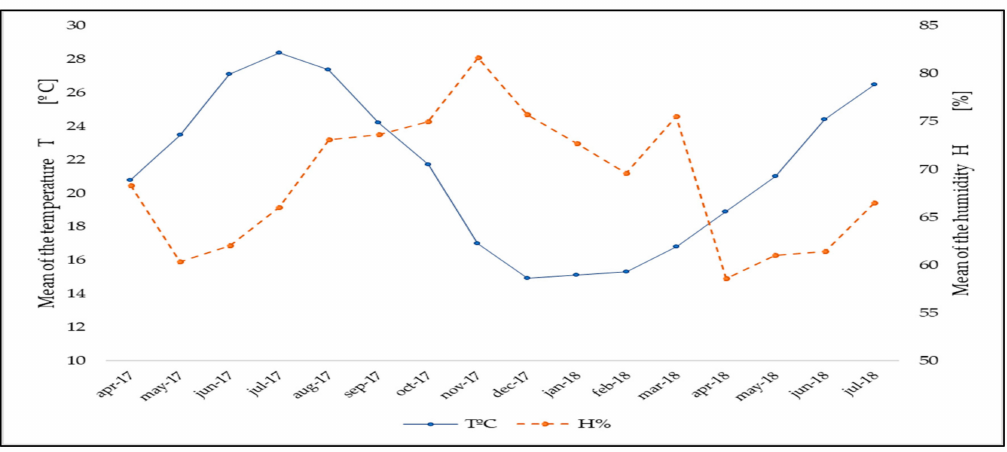
Figure 2. Average of the temperature T (-): and humidity H ( — ) inside the greenhouse during the